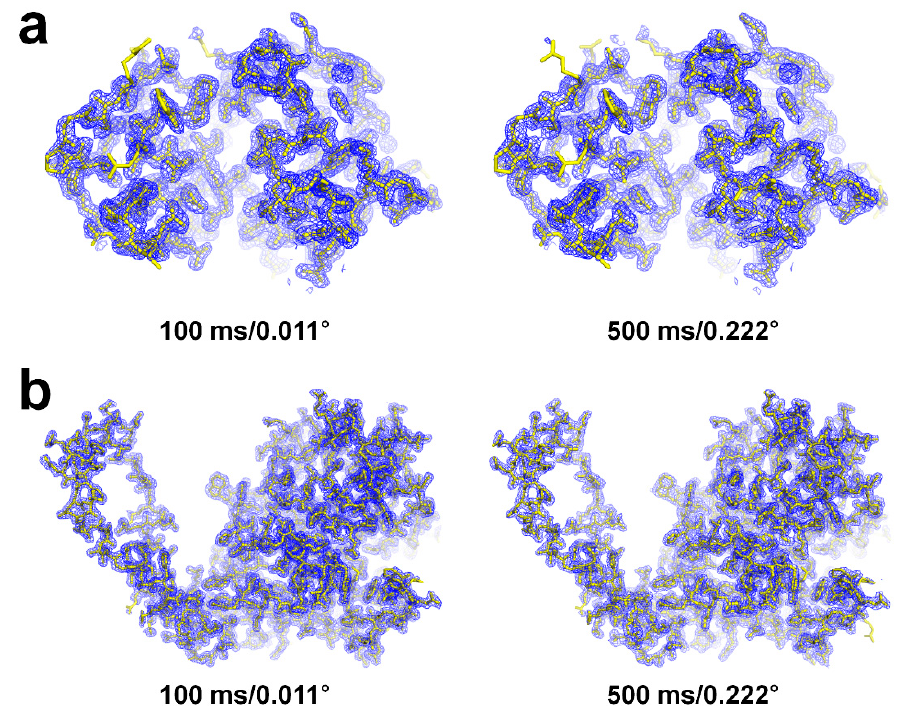
Figure 4. The 2mFo-DFc electron density maps (blue mesh, 1.2 σ ) for whole structure of ( a ) lysozyme, and ( b ) glucose isomerase. Amino acids are shown as yellow sticks.